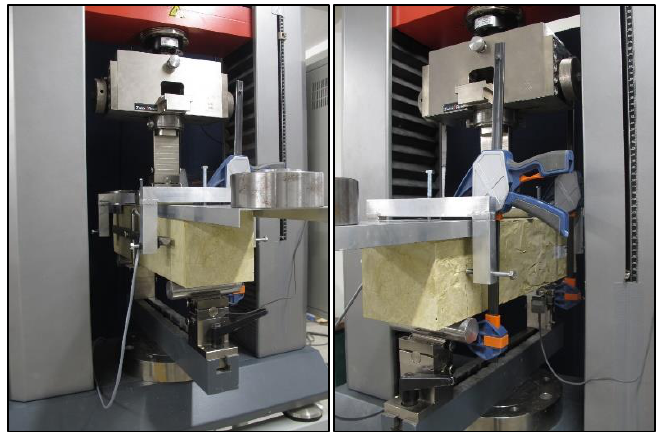
Figure 5. Specimen in a universal testing machine with the frame, counterweights, and sensors.